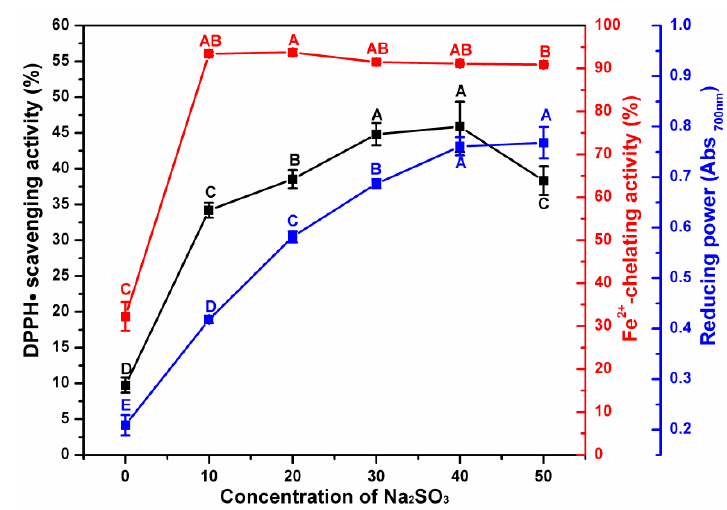
Figure 3. Effect of different concentrations of Na 2 SO 3 on the antioxidant activity of ESM-EH produced by alkaline protease treatment. DPPH•-scavenging activity (black line); Fe 2+ -chelating ability (red line); reducing power (blue line). The different capital letters indicate significant differences ( p < 0.05).